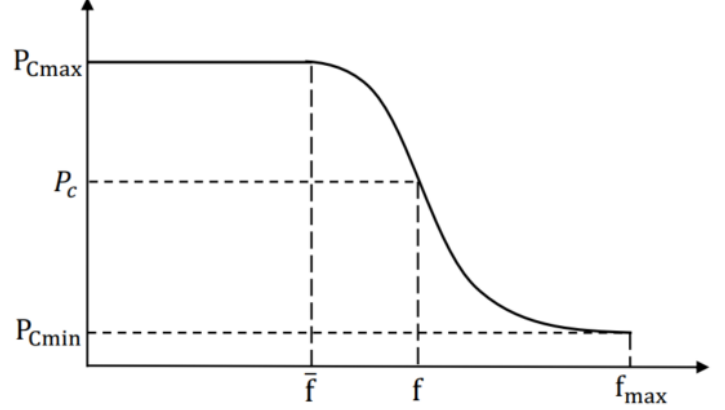
Figure 3. The adaptive adjustment curve of P c